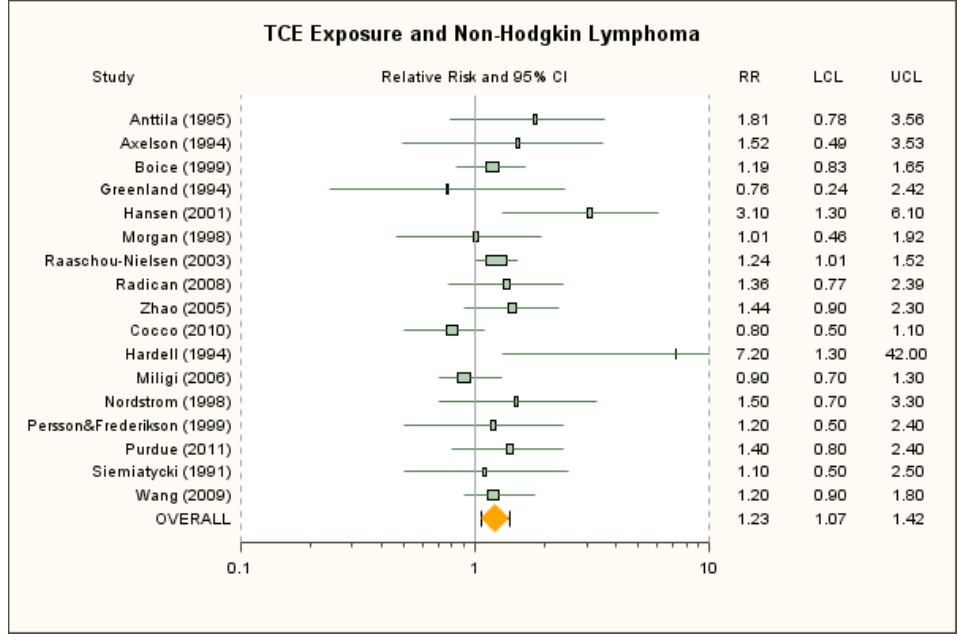
Figure 5. Forest plot of overall TCE exposure and non-Hodgkin lymphoma from random-effects meta-analysis. Individual study results are plotted with 95% confidence intervals. Symbol sizes reflect relative weights of the 17 cohort and case-control studies.